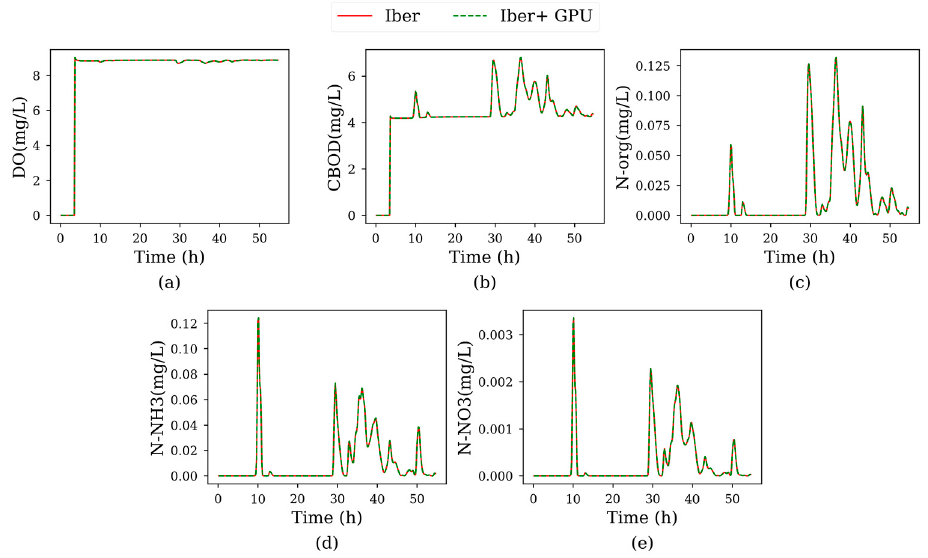
Figure 10. Time series sampled at control point P3 for dissolved oxygen ( a ), carbonaceous biochemical oxygen demand ( b ), organic nitrogen ( c ), ammoniacal nitrogen ( d ) and nitrite ‐ nitrate nitrogen ( e ).